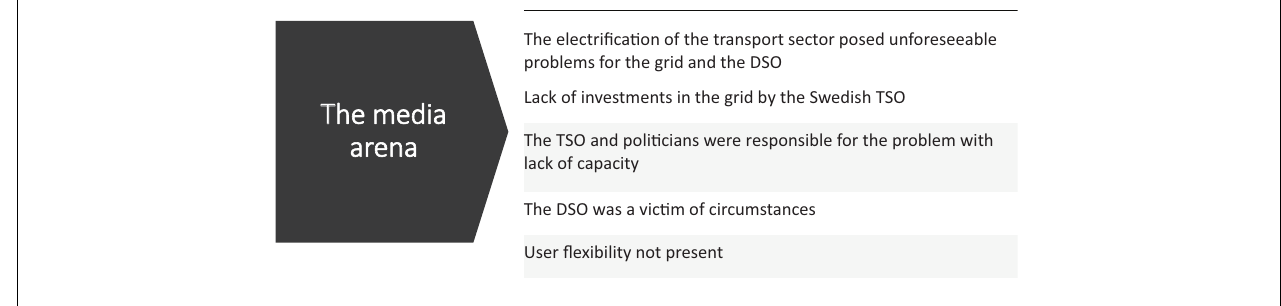
FIGURE 3 | A summary of the main findings in the media arena.